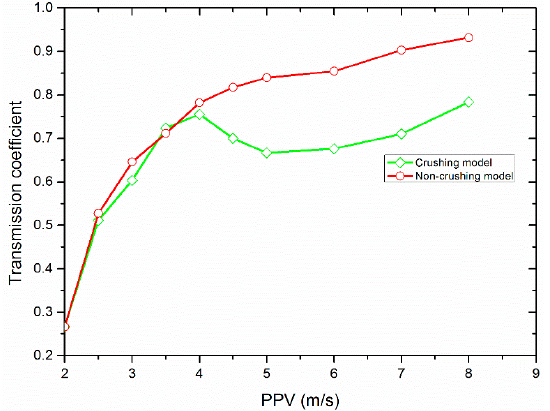
Figure 5. Variation of the transmission coefficient with the PPV of the incident wave.